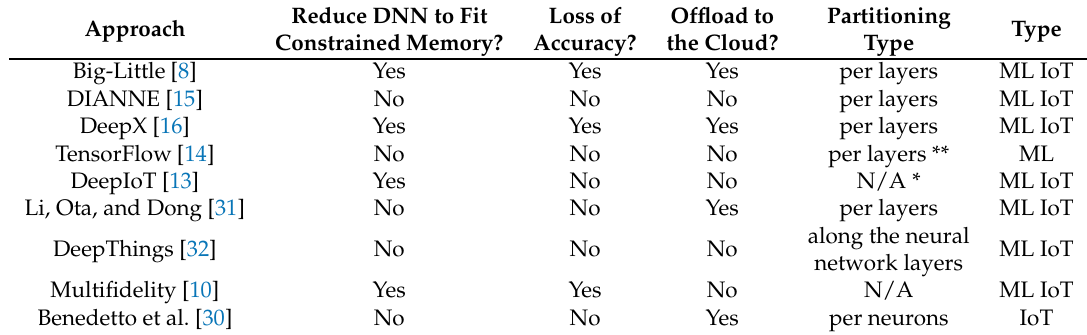
Table 1. Summary of ML and IoT tools discussed in the related